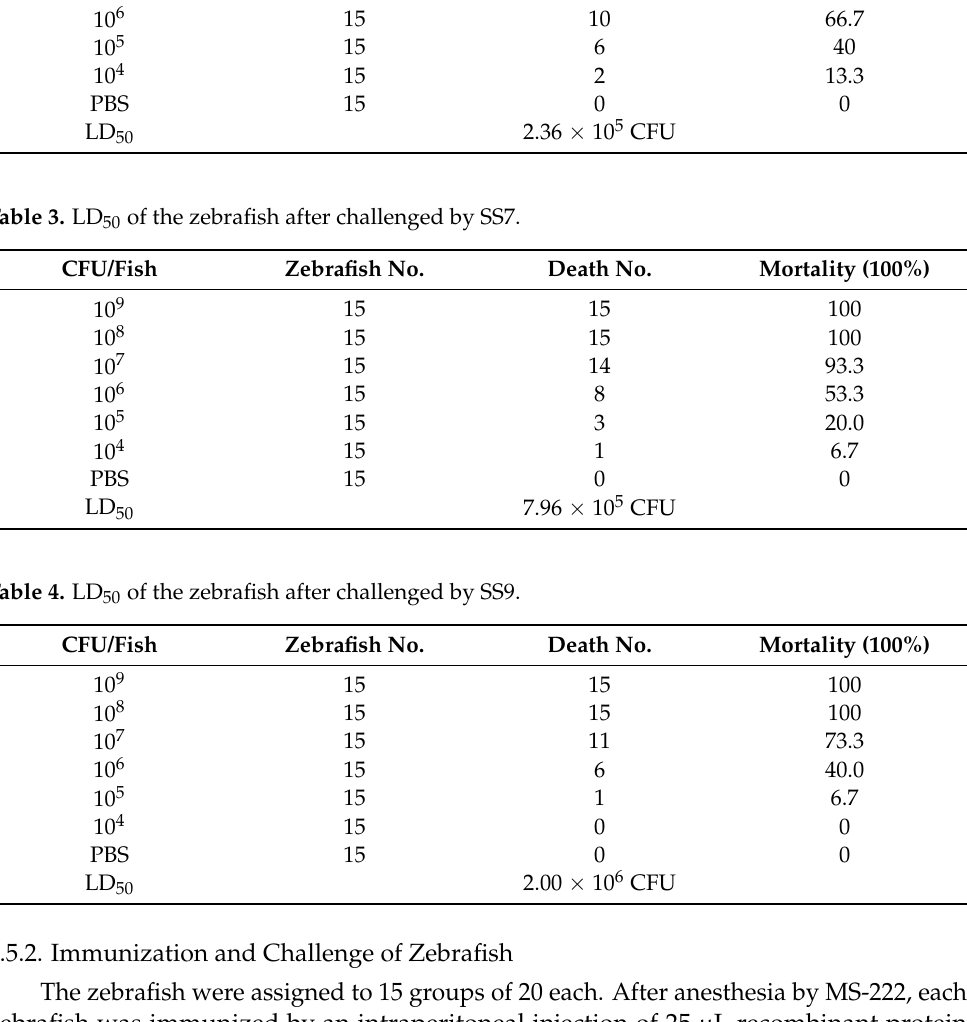
Table 2. LD 50 of the zebrafish after challenged by SS2. CFU/Fish Zebrafish No. Death No.